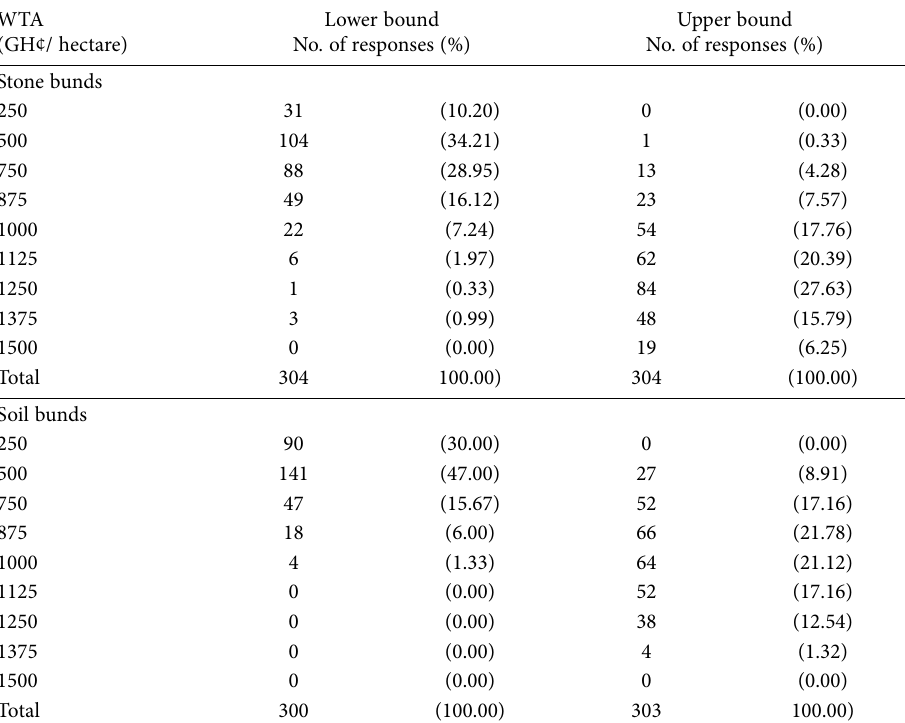
Figures in parentheses are